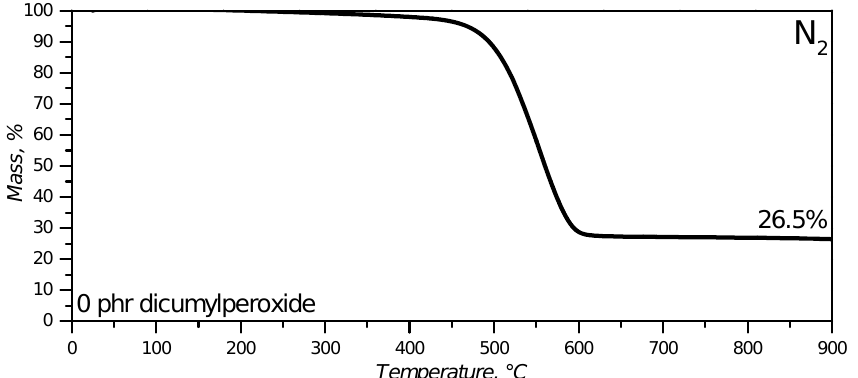
Figure A2. Thermogram for the 0 phr dicumylperoxide silicone rubber under inert atmosphere and 10 K min − 1 heating rate.